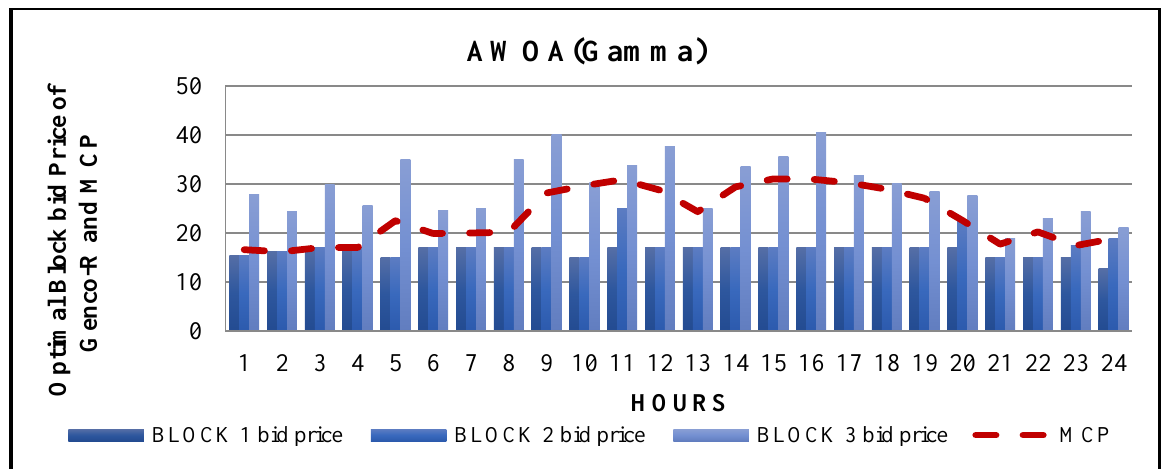
Figure 14. Cumulative Profit Calculated of the Algorithms using Gamma PDF.